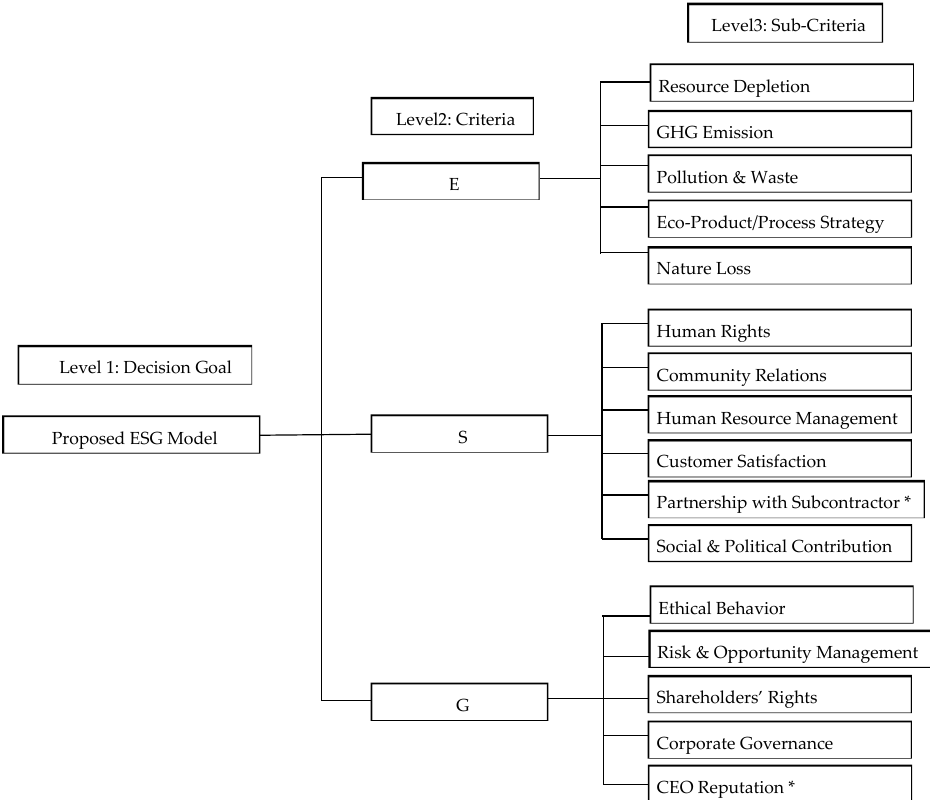
Figure 2. Hierarchical structure and composition of evaluation criteria (* signifies South Korea-specific criteria).